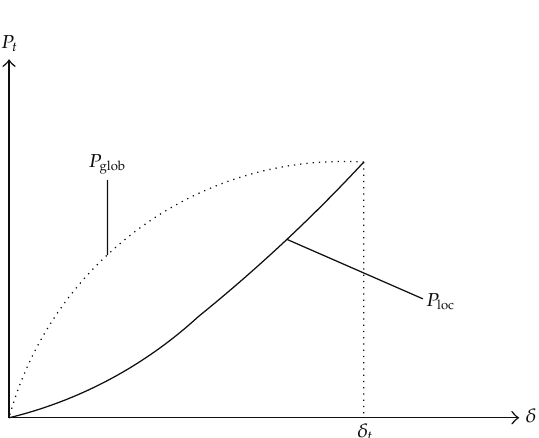
Figure 11: Evaluation of the transition from the local to the global